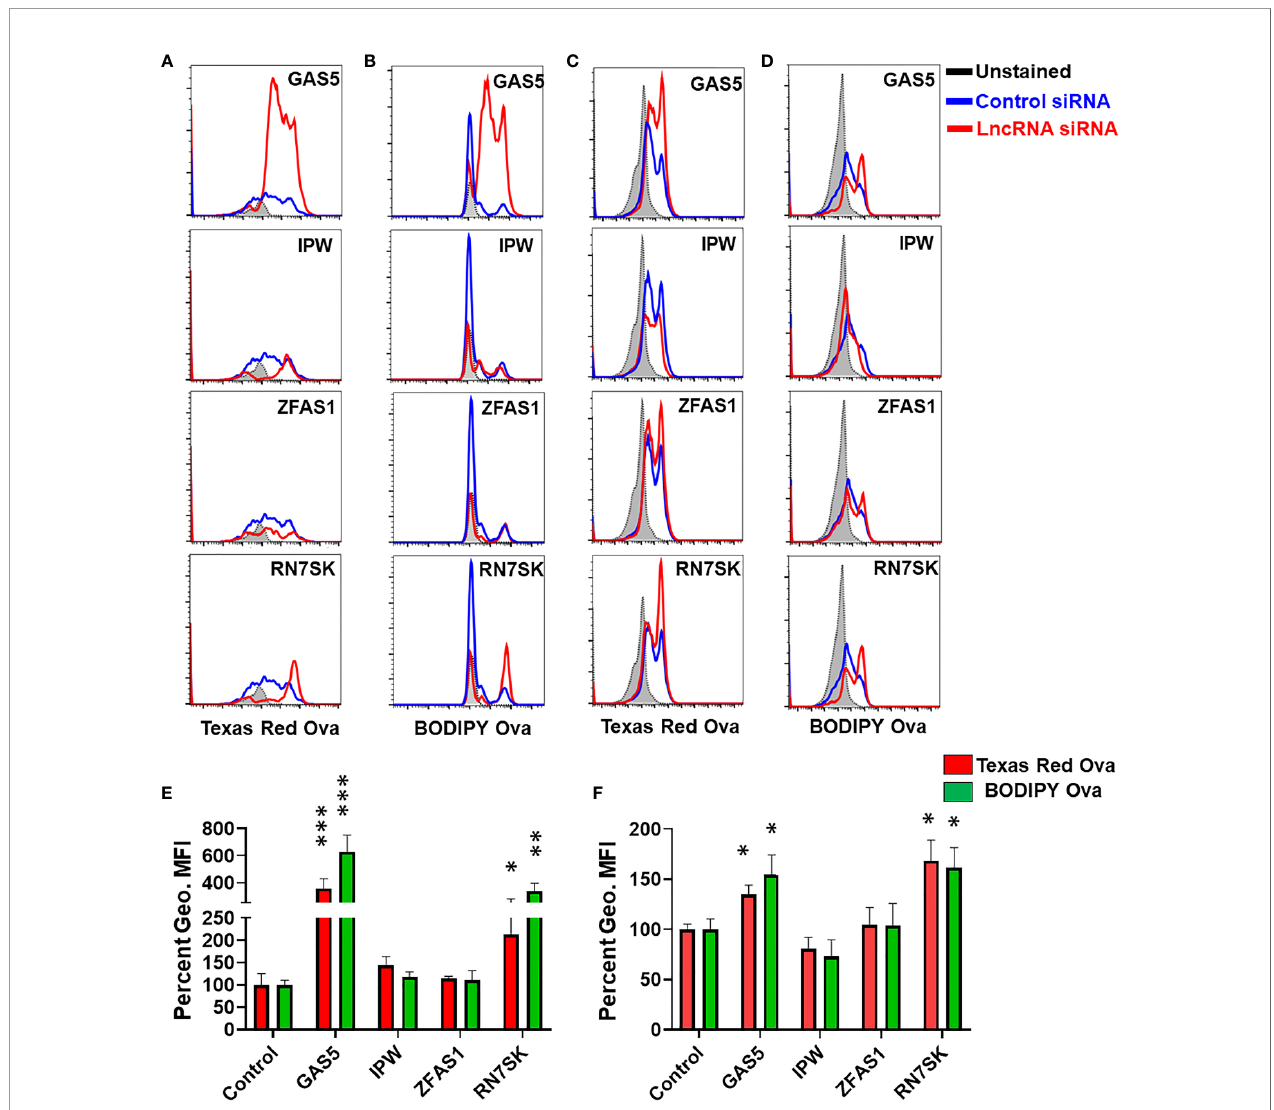
FIGURE 3 | RN7SK and GAS5 silencing enhance antigen uptake and processing in macrophages. Day 3 M1 or M2 macrophages were transfected with 100 nM siRNA targeting GAS5, IPW, ZFAS1, RN7SK or scramble and their impact on antigen uptake and processing was analyzed after 72 h. Antigen uptake and processing were monitored by measuring Texas Red and BODIPY fl uorescence, respectively. (A – D) Overlay of cell population histograms in control or lncRNA targeting siRNA to assess the differences in antigen uptake and processing. (E – F) Differential Mean fl uorescence intensity (MFI) of Texas Red and BODIPY in M1 and M2 macrophages (lncRNA siRNA vs control siRNA). The ratio of geometric mean fl uorescence intensity (geo. MFI) value of control and lncRNA targeting siRNA was obtained and were converted to percentages. Each bar is representative of at least three different experiments and represents the mean ± standard deviation. Two- tailed t-test was used to evaluate statistical signi fi cance. *P < 0.05, **P < 0.01, ***P < 0.001